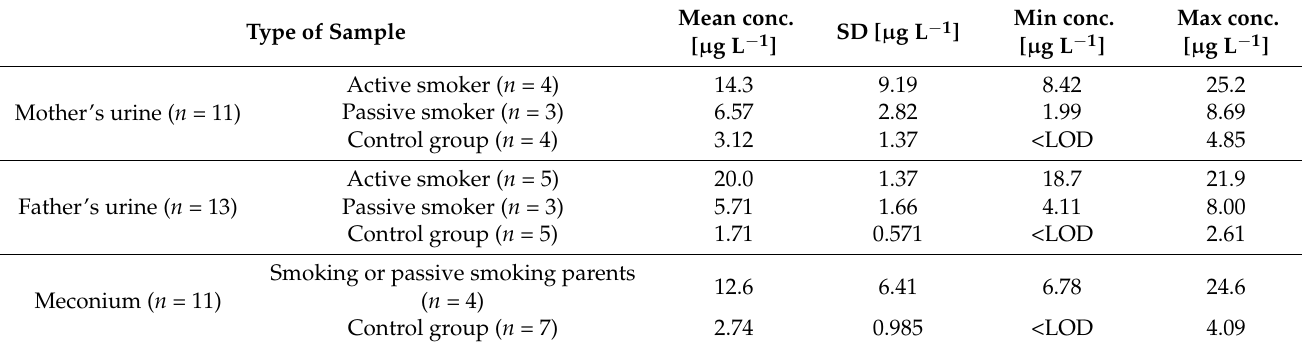
Figure 2. Example chromatograms of a tested smoker ’ s urine (father 21.91 μ g L − 1 , mother 8.69 μ g CN − L − 1 ), and a meconium sample (control group 4.09 μ g L − 1 ). Table 3. Concentrations of cyanide in the studied biological